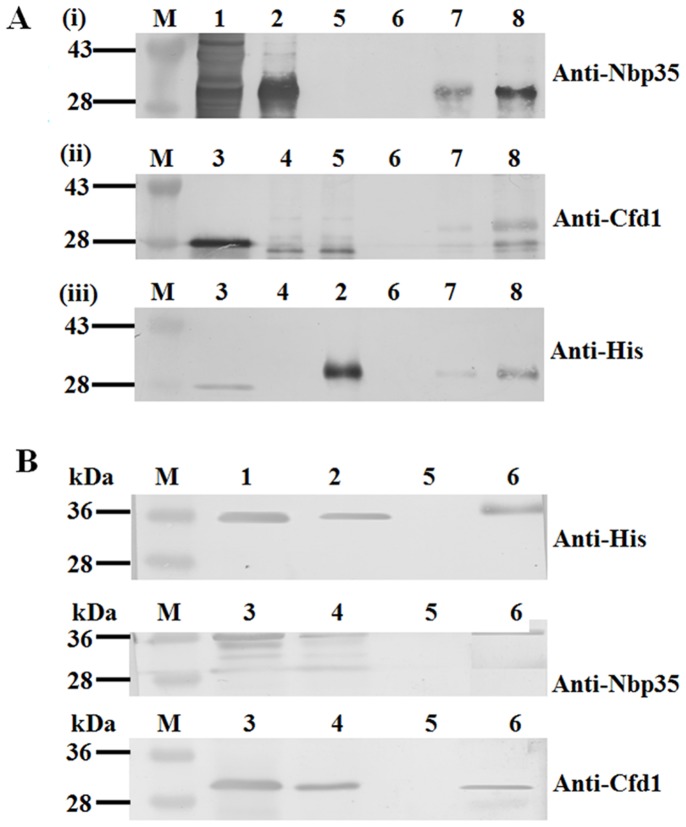
Interaction study between Cfd1 and Nbp35 proteins.(A) Co-purification using recombinant Nbp35 and thrombin digested Cfd1; Immunoblots of fractions obtained from co-purification experiment as described in material and methods probed with different antibodies (i) Anti-Nbp35 (ii) Anti-Cfd1 (iii) Anti-His antibodies for interaction between recombinant Nbp35 and thrombin digested Cfd1 proteins. Lane M- represents molecular weight proteins marker, lane 1- E. coli lysate overexpressing rNbp35, lane 2- purified rNbp35, lane 3- undigested rCfd1, lane 4- digested rCfd1, lane 5- wash (60 mM imidazole), lane 6 final wash did not show any proteins in all blots, lane 7- eluate (200 mM imidazole), lane 8- eluate (500 mM imidazole). (B) Pull down assay using rNbp35 and E. histolytica lysate: Ni+2-NTA bound rNbp35 was incubated with E. histolytica lysate as described in material and methods for pull down assay and eluate (500 mM imidazole) fraction was subjected to immunoblot analysis proved different antibodies (upper panel) Anti-His (middle panel) Anti-Nbp35 (lower panel) Anti-Cfd1 antibodies for rNbp35 and endogenous amoebic Cfd1 interaction. Lane M- represents molecular weight proteins marker, lane 1- total E. coli lysate expressed rNbp35, lane 2- supernatant rNbp35, lane 3- total amoebic lysate, lane 4- amoebic lysate flow through, lane 5 final wash did not show any proteins in all blots, lane 6- eluate (500 mM imidazole).